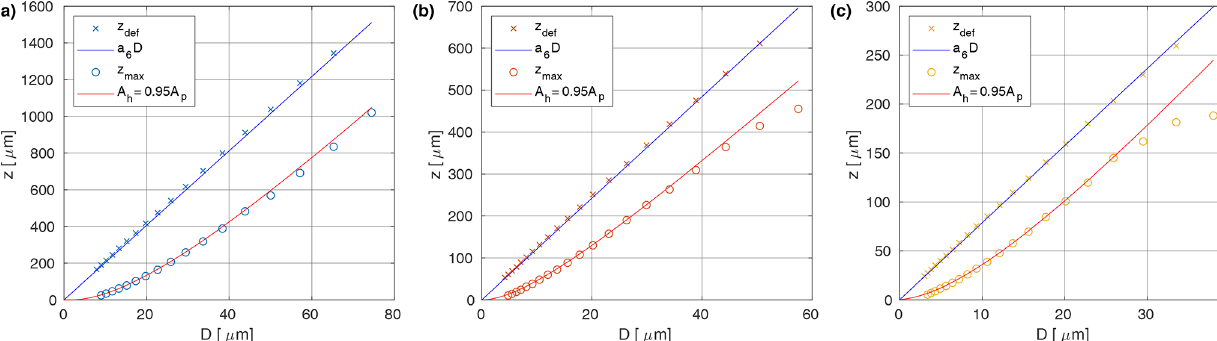
Figure 5. The maximum range of the defocus distance z for each size bin as derived from the volumes listed in the summary file (crosses), the corresponding actual maximum values z max found in the experimental data (circles), and two analytical approximations: the default z def and the corrected z 95 . Measurement series are shown for three lens magnification settings: (a) × 1, (b) × 2, (c) ×